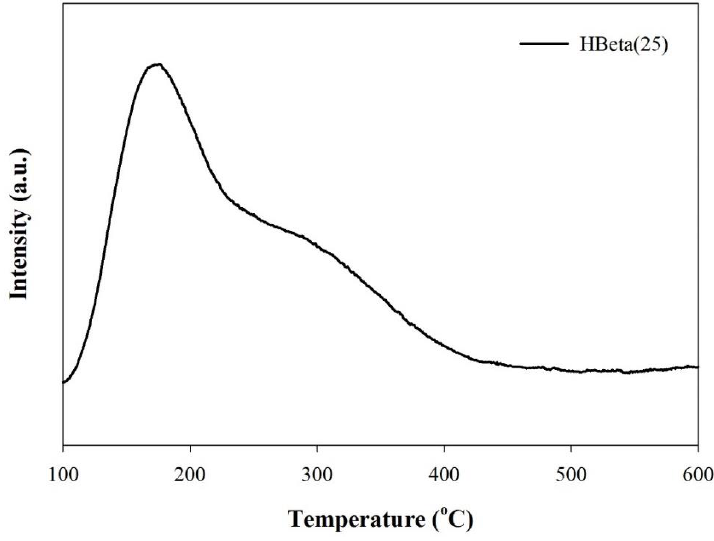
Figure 5. NH 3 -TPD profiles of HBeta(25).